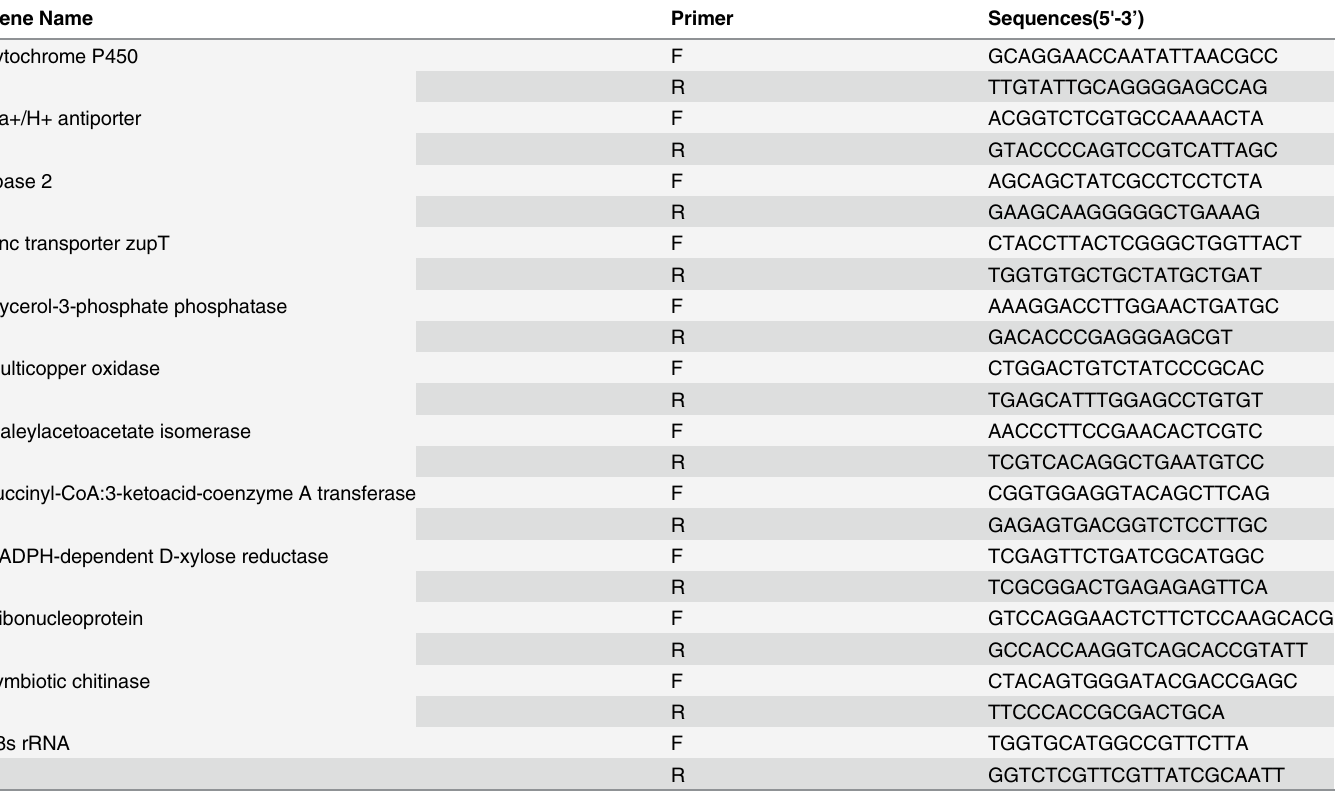
Table 1. The primer in real-time